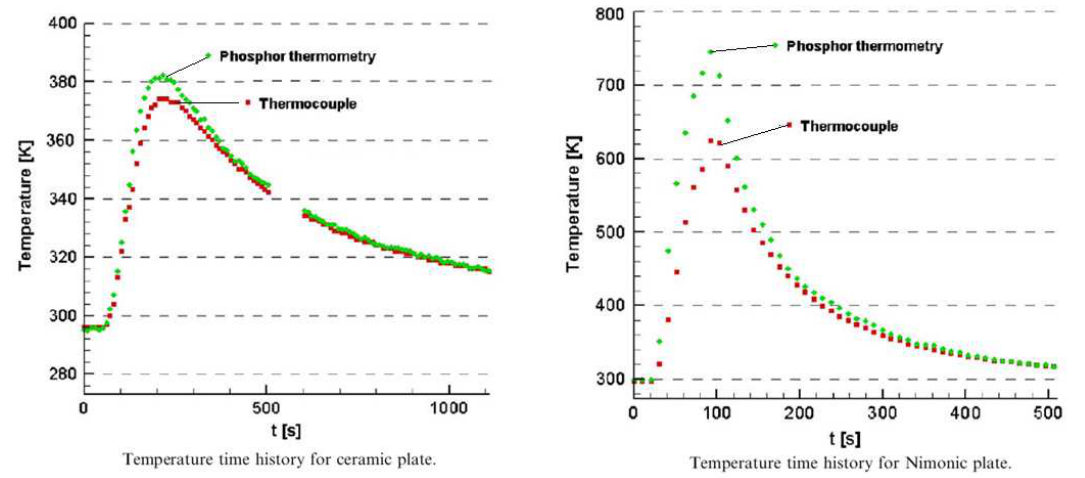
Figure 43. Temperature history for ceramic and nimonic plates. Taken from Heyes et al .